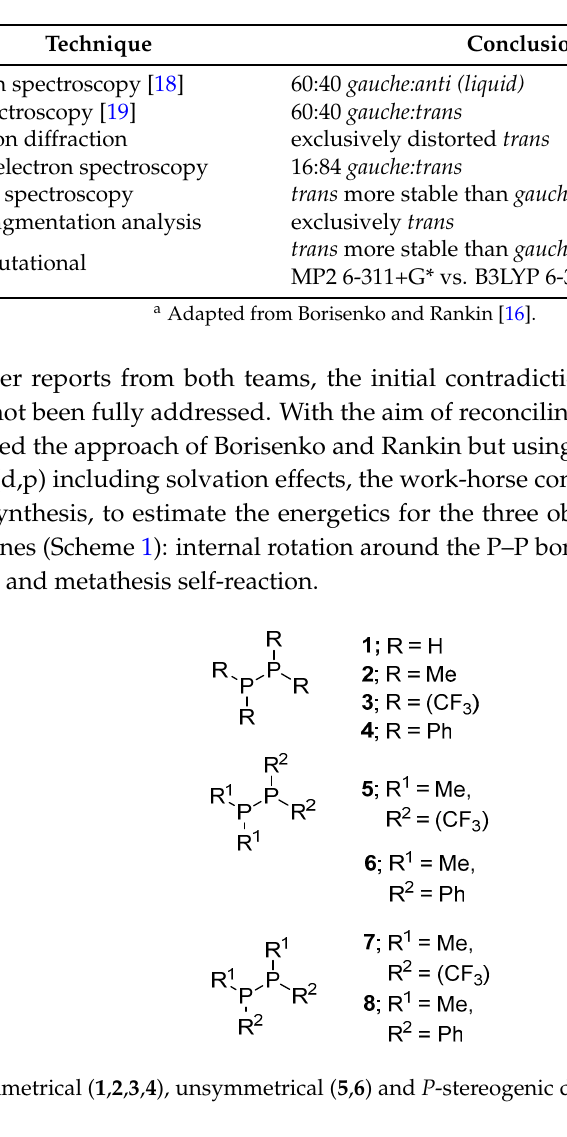
Table 1. Conflicting conclusions from literature regarding the rotational configuration of 2 a .